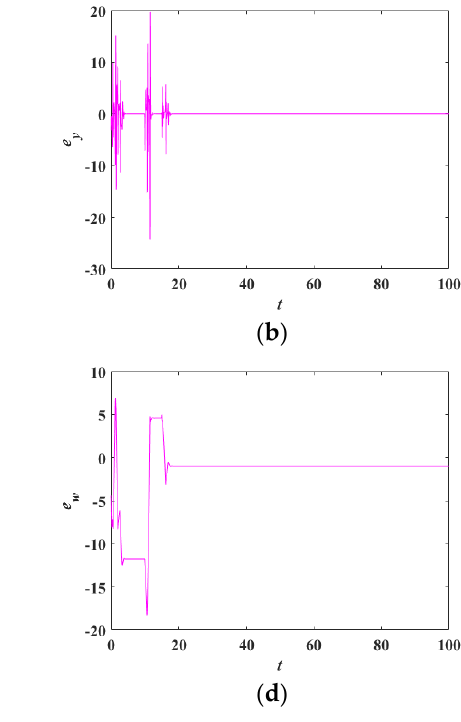
Figure 2. Error curves, ( a ) e x , ( b ) e y , ( c ) e z , ( d ) e w .